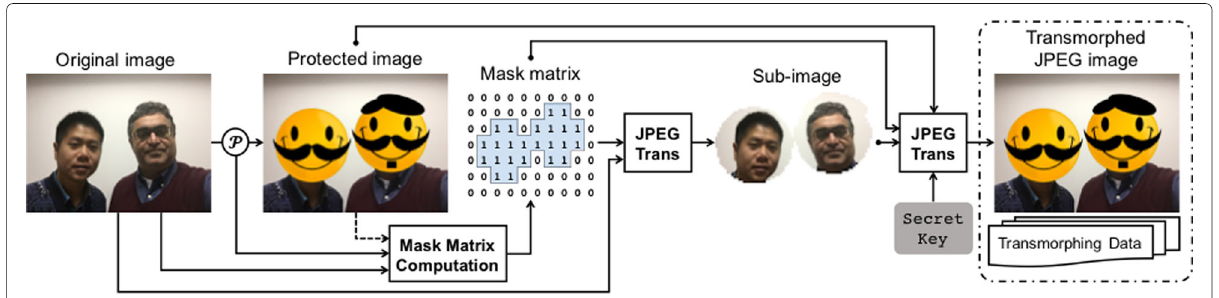
Fig. 5 Privacy protection of a JPEG image with secure transmorphing